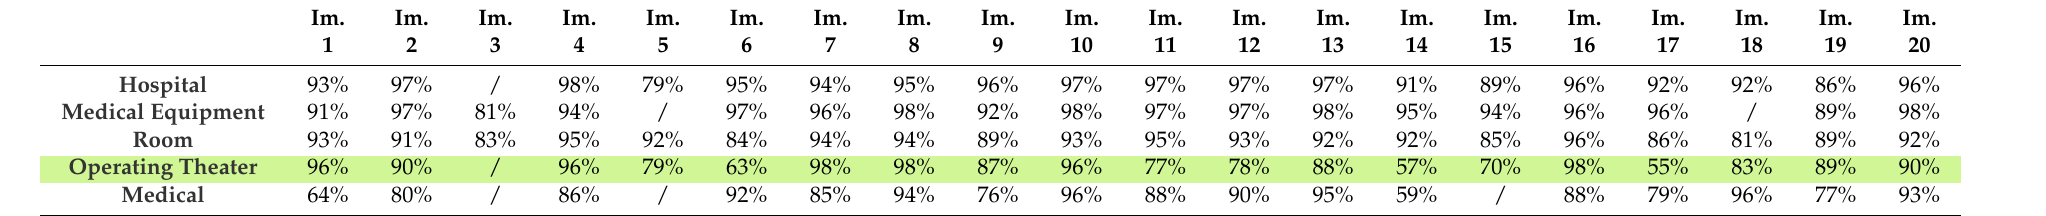
Table A1. Percentage of confidence obtained with Google Vision API for the “surgery” IU. Each column corresponds to Image 1 to 20. Im. Im.